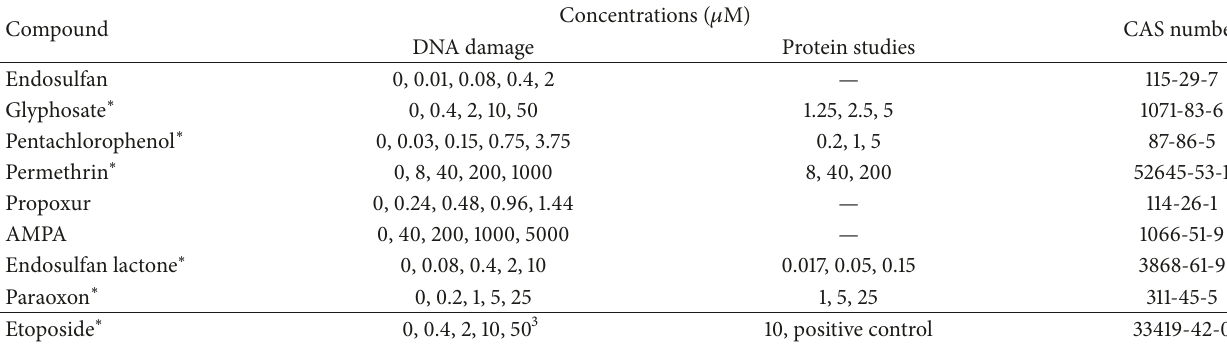
Table 1: Treatments applied for DSB and protein